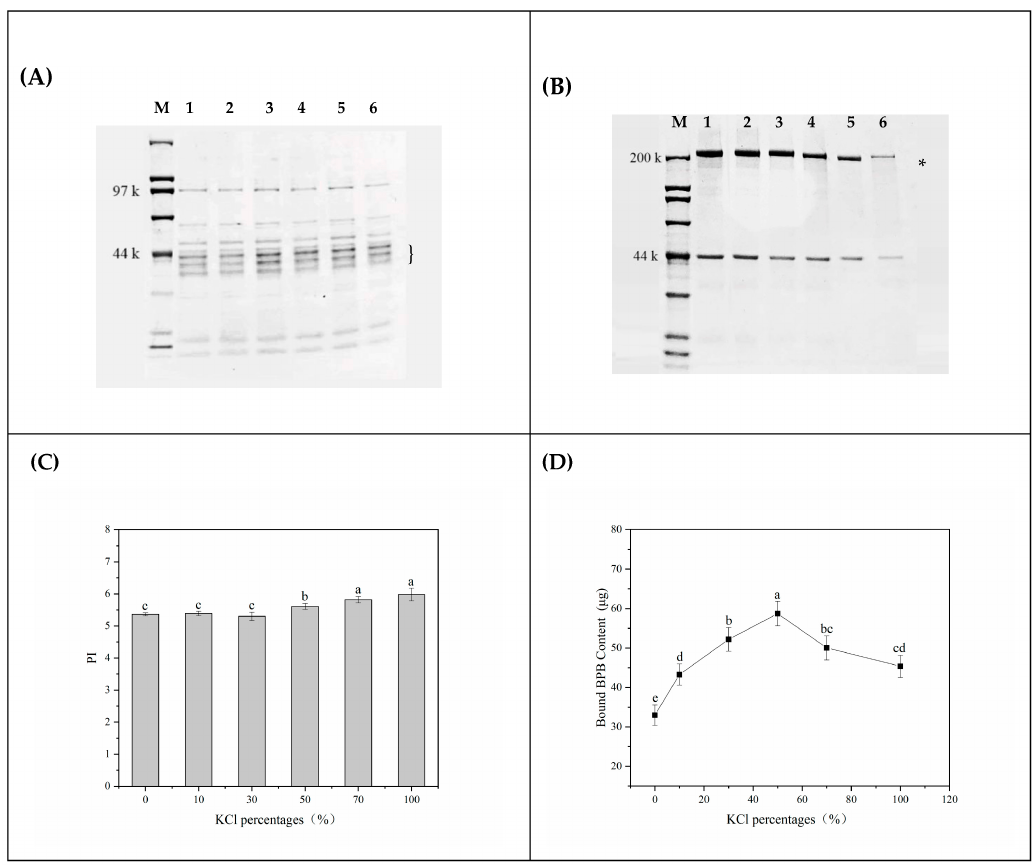
Figure 3. Change in protein structure stability of salted tilapia fillets as affected by different by-products. ( A ) SDS-PAGE profiles of water-soluble proteins; ( B ) SDS-PAGE profiles of myofibrillar proteins; ( C ) PI; ( D ) protein surface hydrophobicity. M: marker; 1, 2, 3, 4, 5, 6: myofibrillar proteins with different replacement proportions of NaCl with KCl (0%, 10%, 30%, 50%, 70%, 100%) in lightly salted tilapia fillets; The parentheses and asterisk indicate the band with a low molecular weight of approximately 15~40 kDa and a molecular weight of around 220 kDa in proteins fraction protein affected by KCl replacements. Values with different lowercase letters are significantly different at p <